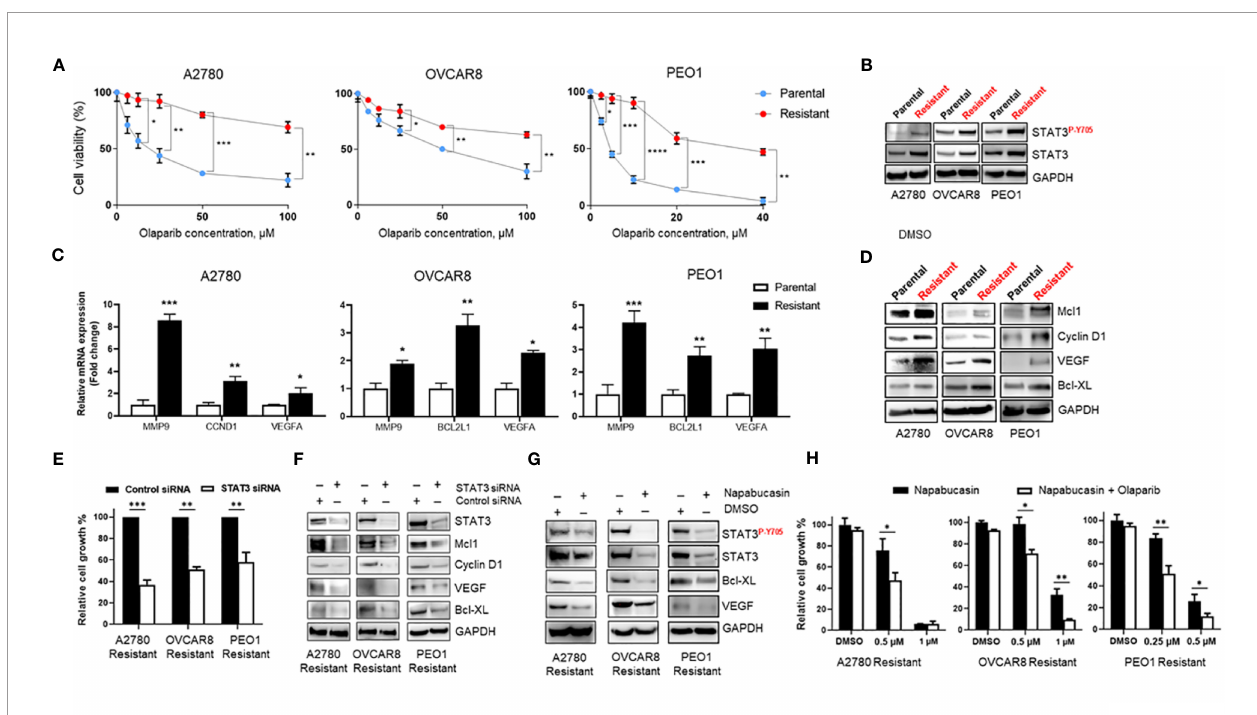
FIGURE 2 | STAT3 activation is elevated in Olaparib-resistant cell lines and genetic or pharmacological STAT3 targeting inhibits Olaparib-resistant tumor cell proliferation (A) Drug-response curves of survival after Olaparib treatment of parental and acquired Olaparib-resistant A2780, OVCAR8 and PEO1 cells at 72 h. Shown are representative graphs from three independent experiments as means ± SD (n = 4). Unpaired two-tailed Student t-test of Olaparib-resistant cells performed against parental controls at increasing drug concentrations. Shown are means ± SD. *p<0.05, **p<0.01, ***p<0.001, and ****p<0.0001. (B) Western blot showing activated (P- Y705) and total STAT3 levels in parental and Olaparib-resistant A2780, OVCAR8, and PEO1 cells. GAPDH staining served as a loading control. (C) Real-time PCR measuring STAT3 target gene MMP9, CCND1, BCL2L1 and VEGFA mRNA levels in parental and Olaparib-resistant A2780, OVCAR8 and PEO1 cells. Gene expression was normalized to the housekeeper gene ACTB and relative expressions are shown. Unpaired two-tailed Student t-test of Olaparib-resistant cells performed against parental controls. Shown are means ± SD (n = 3). *p<0.05, **p<0.001, and ***p<0.0001. (D) Western blot analyzing STAT3 target gene levels in parental and Olaparib-resistant A2780, OVCAR8, and PEO1 cells. GAPDH staining served as a loading control. (E) Cell proliferation analysis of Olaparib-resistant A2780, OVCAR8, and PEO1 cells transfected with either control or STAT3 siRNA. Unpaired two-tailed Student t-test was performed against siRNA controls. Shown are means ± SD (n = 4). (F) Western blotting measuring STAT3 target gene levels in Olaparib-resistant A2780, OVCAR8, and PEO1 cells incubated either with either scramble or STAT3 siRNA for 72 h. GAPDH staining served as a loading control. (G) Western blotting showing STAT3 target gene levels in Olaparib-resistant A2780, OVCAR8, and PEO1 cells treated either with 0.1% DMSO or Napabucasin (0.5 µM for A2780 Resistant and OVCAR8 Resistant, 0.25 µM for PEO1 Resistant cells) for 72 h. GAPDH staining served as a loading control. (H) Cell proliferation assay showing the indicated Napabucasin concentrations kill and sensitize Olaparib-resistant ovarian cancer cells to either 40 µM (for A2780 Resistant and OVCAR8 Resistant) or 10 µM (for PEO1 Resistant) Olaparib. Unpaired two-tailed Student t-test of combinatorial Napabucasin and Olaparib treatment performed against single Napabucasin treatment. Shown are means ± SD (n=3). *p<0.05,